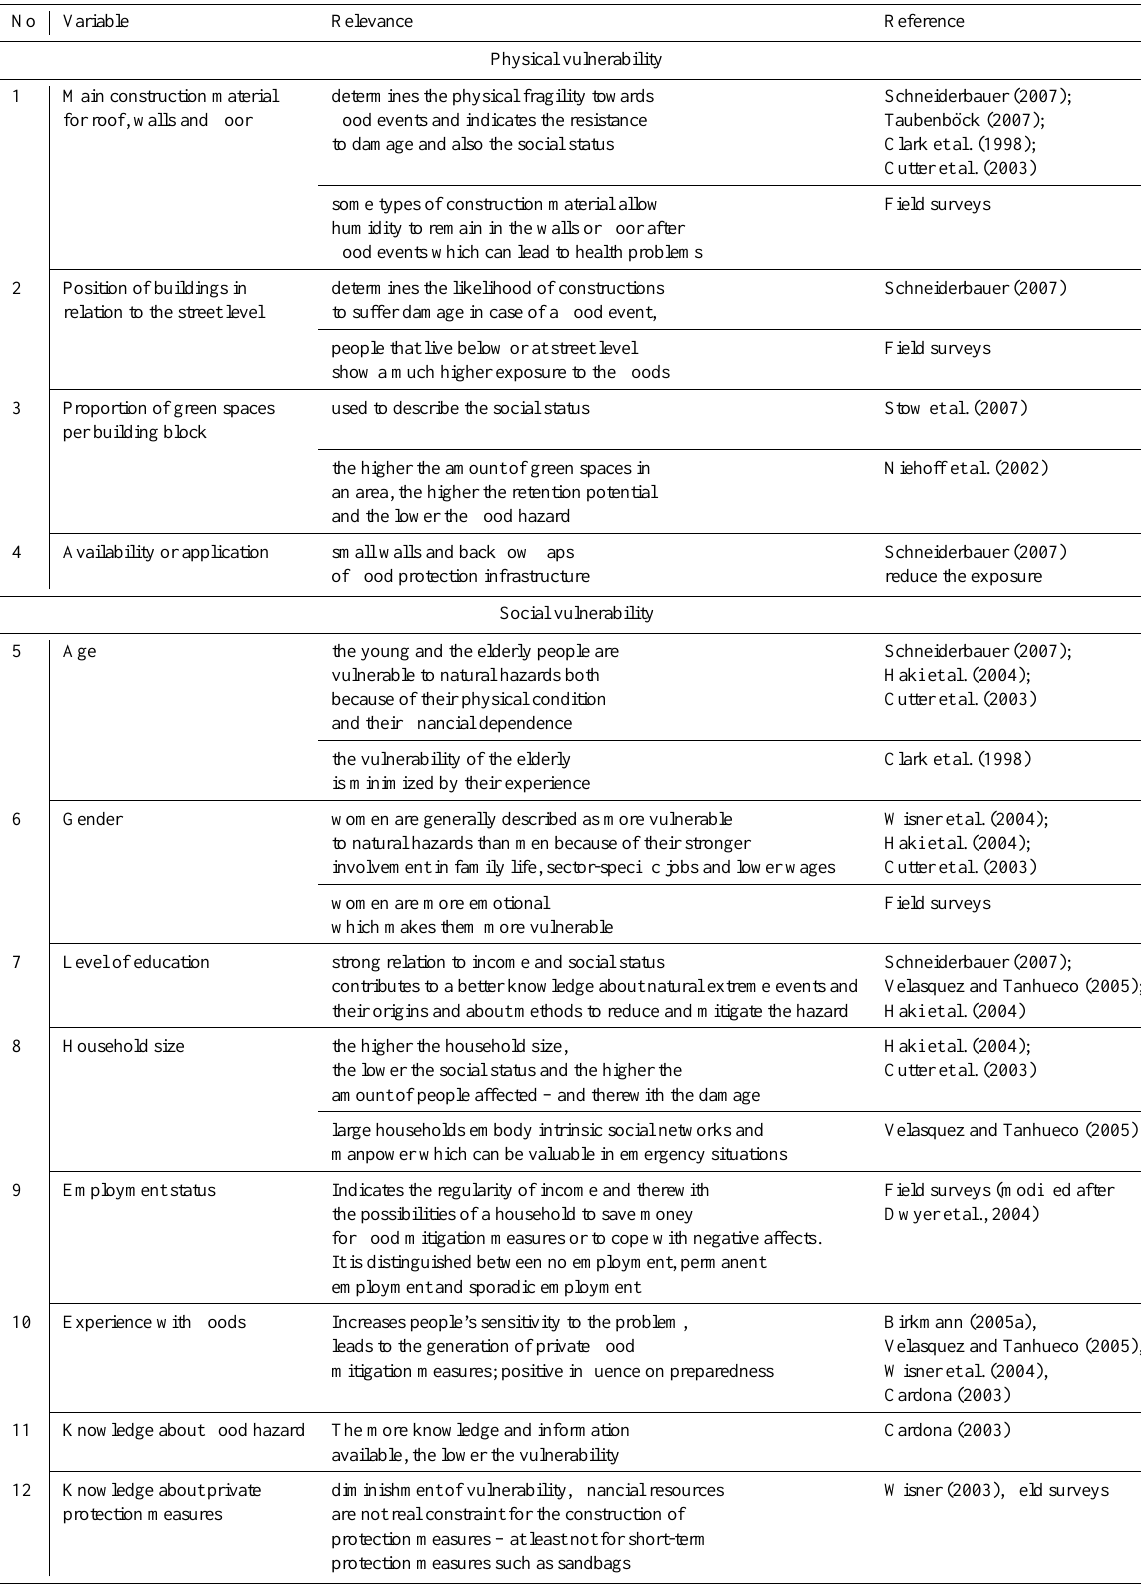
Table 2. Variables relevant for the assessment of flood vulnerability in the study